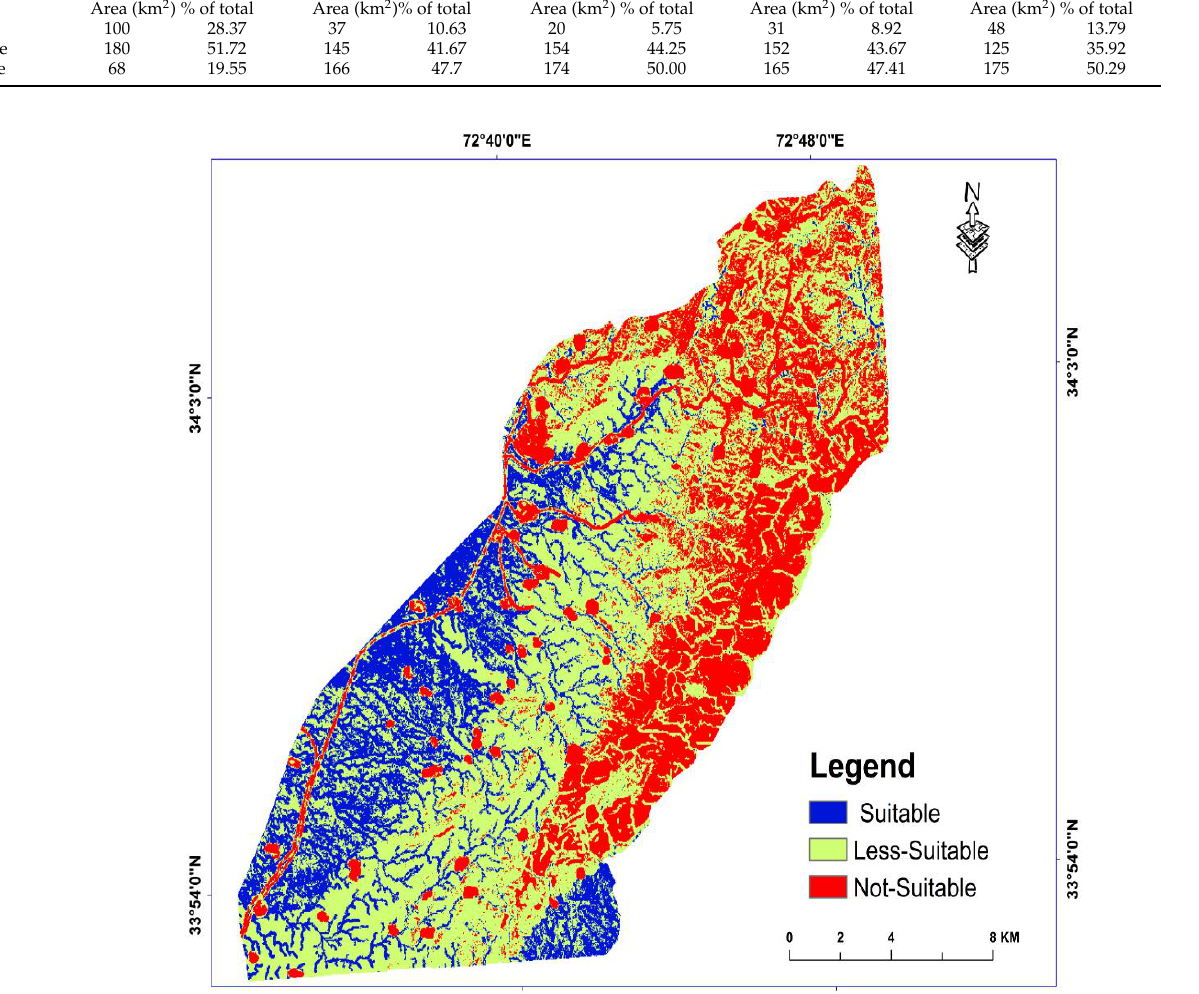
Table 5. Distribution of potential sites for RWH and related structures in the study area.